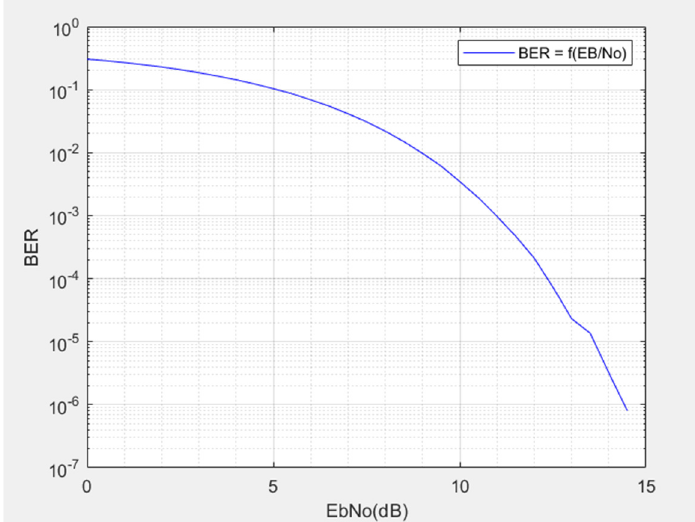
Figure 11. BER as a function of signal to noise